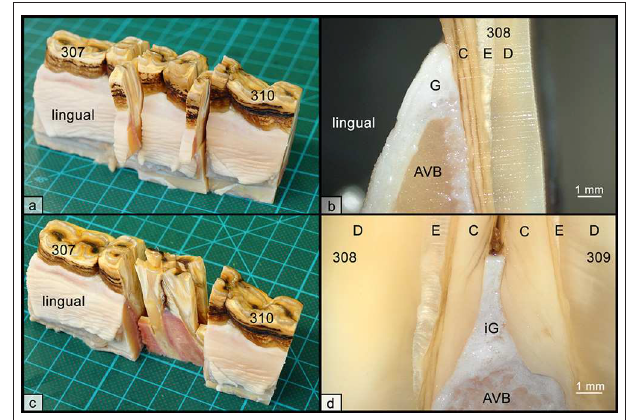
FIGURE 1 | Histologic sampling collection, exemplary shown for teeth 308 and 309. (a) Non-interdental samples were collected by transverse sectioning of teeth 308 and 309. Sections were further divided to obtain separated specimens from the lingual and buccal aspect. (b) Each specimen contained the gingiva (G), parts of the alveolar bone (AVB), and dental substances, i.e., cementum (C), enamel (E), and dentin (D). (c) Interdental samples were collected by sagittal sections through teeth 308 and 309. (d) Each specimen contained the interdental gingiva (iG), attached to alveolar bone (AVB) and dental substances, i.e., cementum (C), enamel (E), and dentin